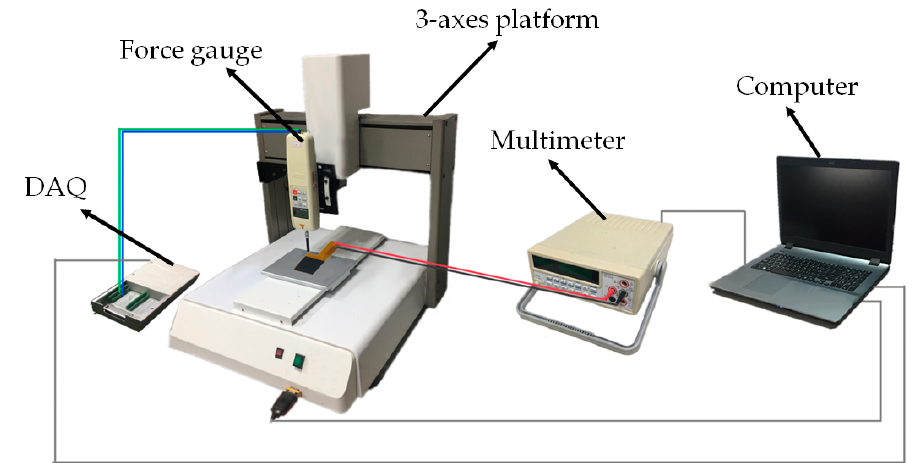
Figure 5. Experimental setup for testing the sensor array.